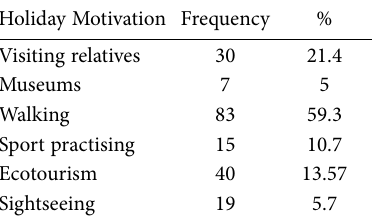
Table 2. Holiday motivation declared